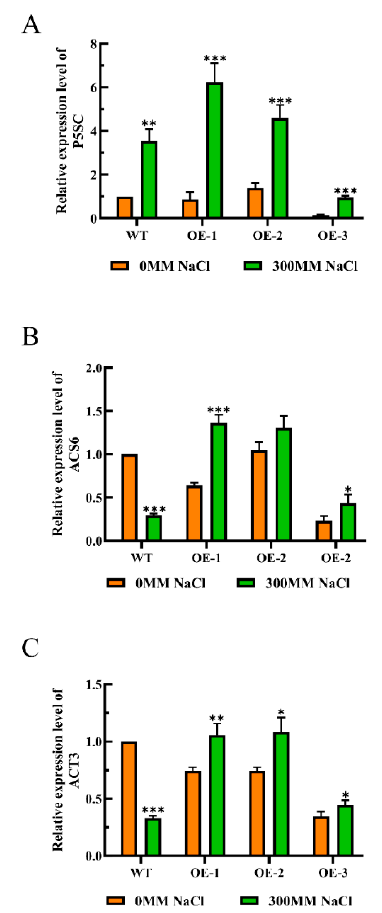
Figure 6. LcMKK2 promoted the expression of salt-related genes. ( A – C ) Quantification of P5SC ( A ), ACS6 ( B ), and ACT3 ( C ) expression in wild-type (WT) plants and three separate LcMKK2-OE transgenic lines (OE-1, OE-2, and OE-3) when untreated and treated with 300 mM NaCl on soil for 2 h. Data represent the mean ± SD from three technical replicates. An ANOVA test was used for statistical analysis. *** p < 0.001; ** p < 0.01; * p < 0.05.